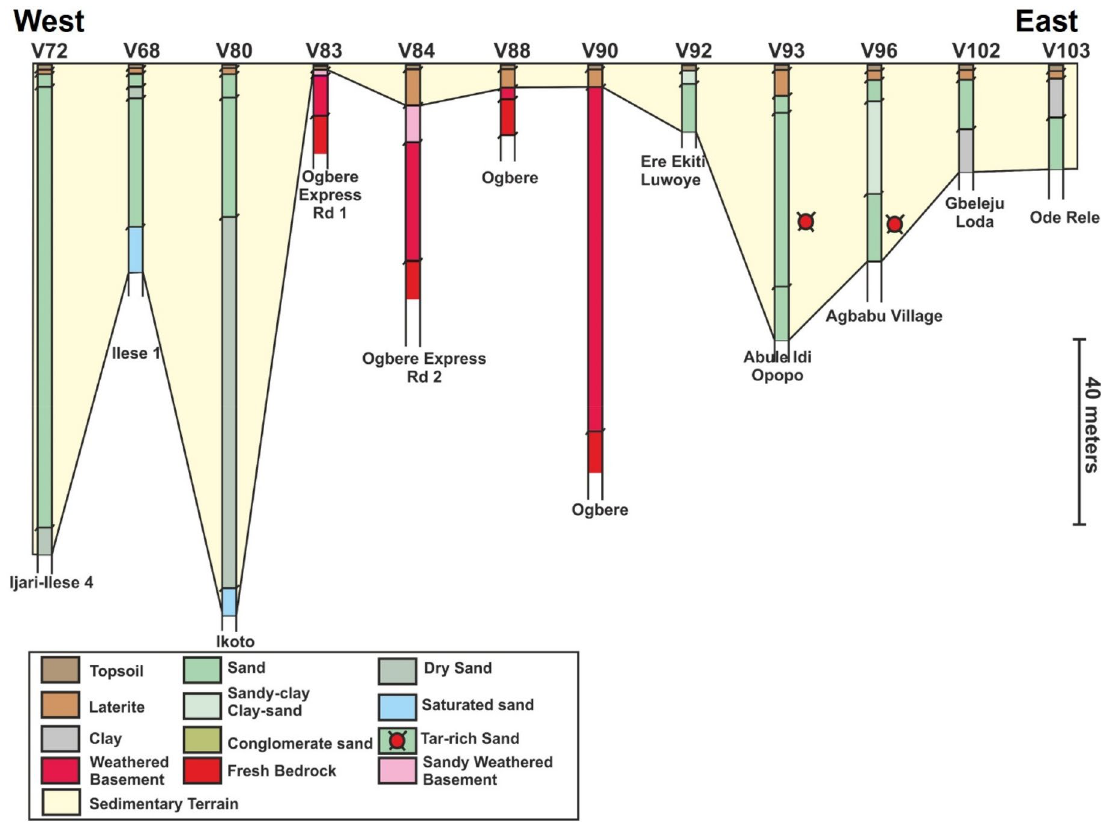
Figure 7. Regional VES profile 2 from Ilishan through Ago-Iwoye to Ogbere showing the transition from sedimentary terrain to basement complex rocks. The location of the VES transect is shown in Fig. 1a.